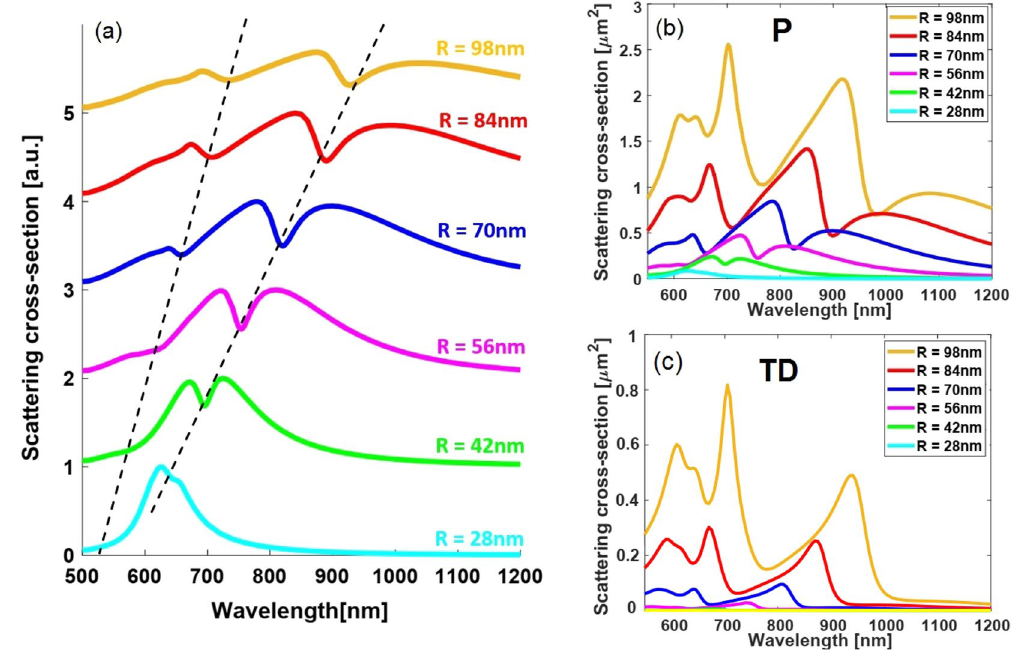
Figure 3. ( a ) Total SCS spectra of the oligomer structure illuminated by a normally-incident plane wave for different radii of particles, while the ratio between the radius and the gap between the particles being fixed. The remaining optical and geometrical parameters are the same as Fig.1. Contribution of the electric (P) and toroidal (TD) dipole multipoles are respectively illustrated in ( b - c ) to provide additional information regarding evolution of the Fano-like spectral line